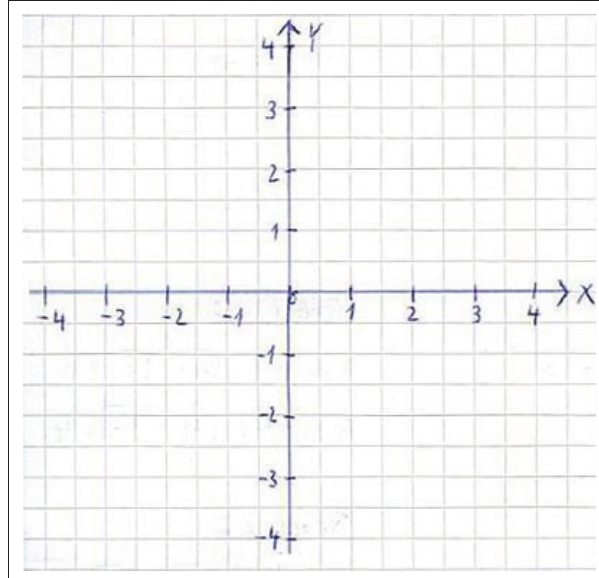
FIGURE 2: Cartesian coordinate